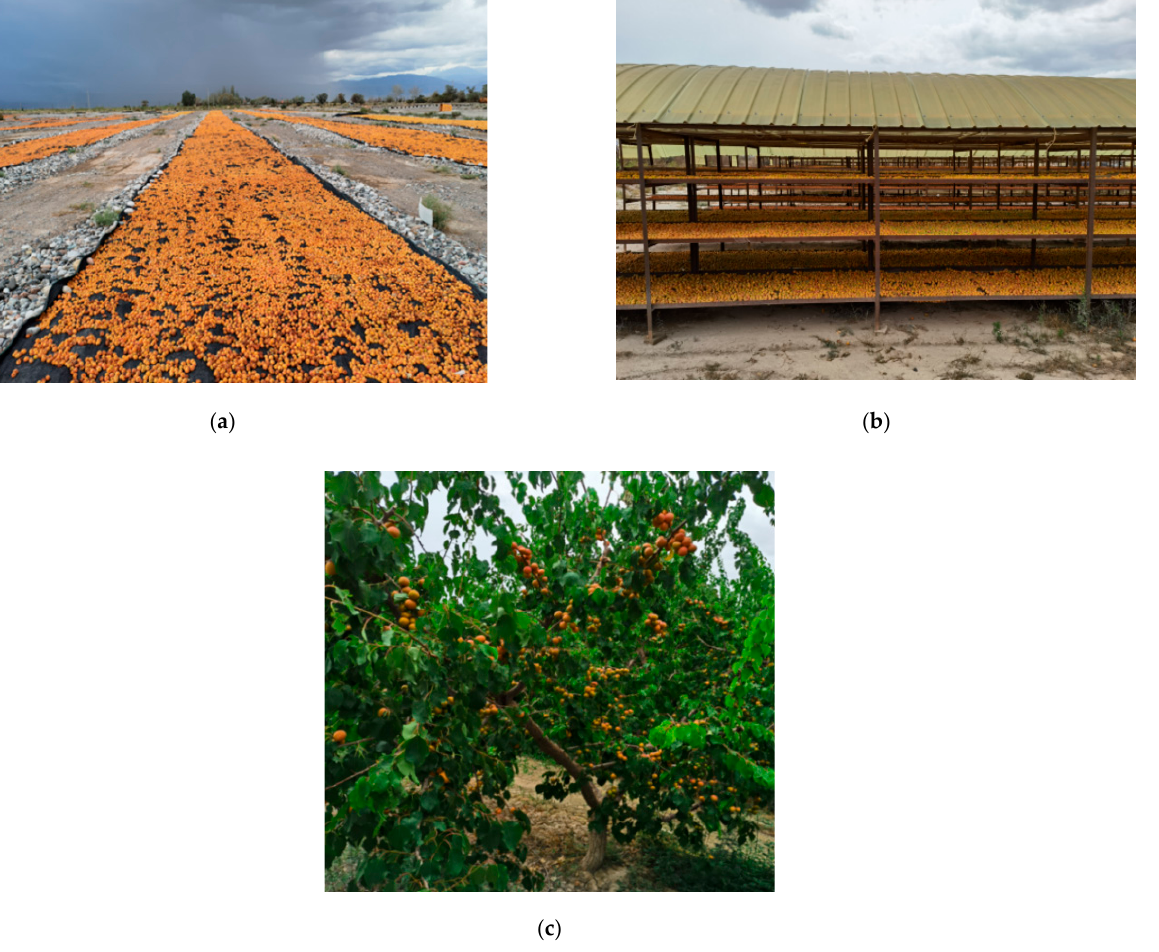
Figure 1. Three drying methods for apricot. ( a ) Hanging dry Gobi Desert Natural laying drying method, ( b ) Ventilation and drying method of drying room, ( c ) Natural fruit hanging method on trees.